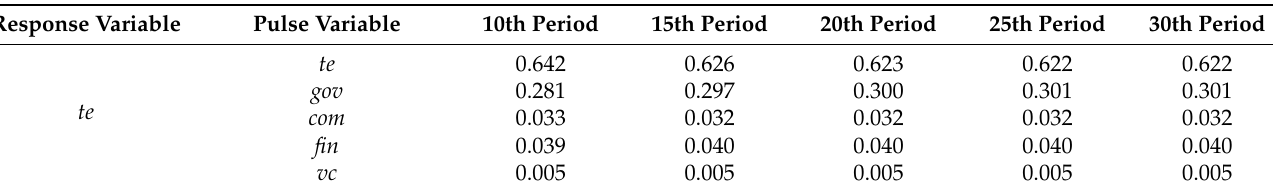
Table 5. Variance decomposition results of